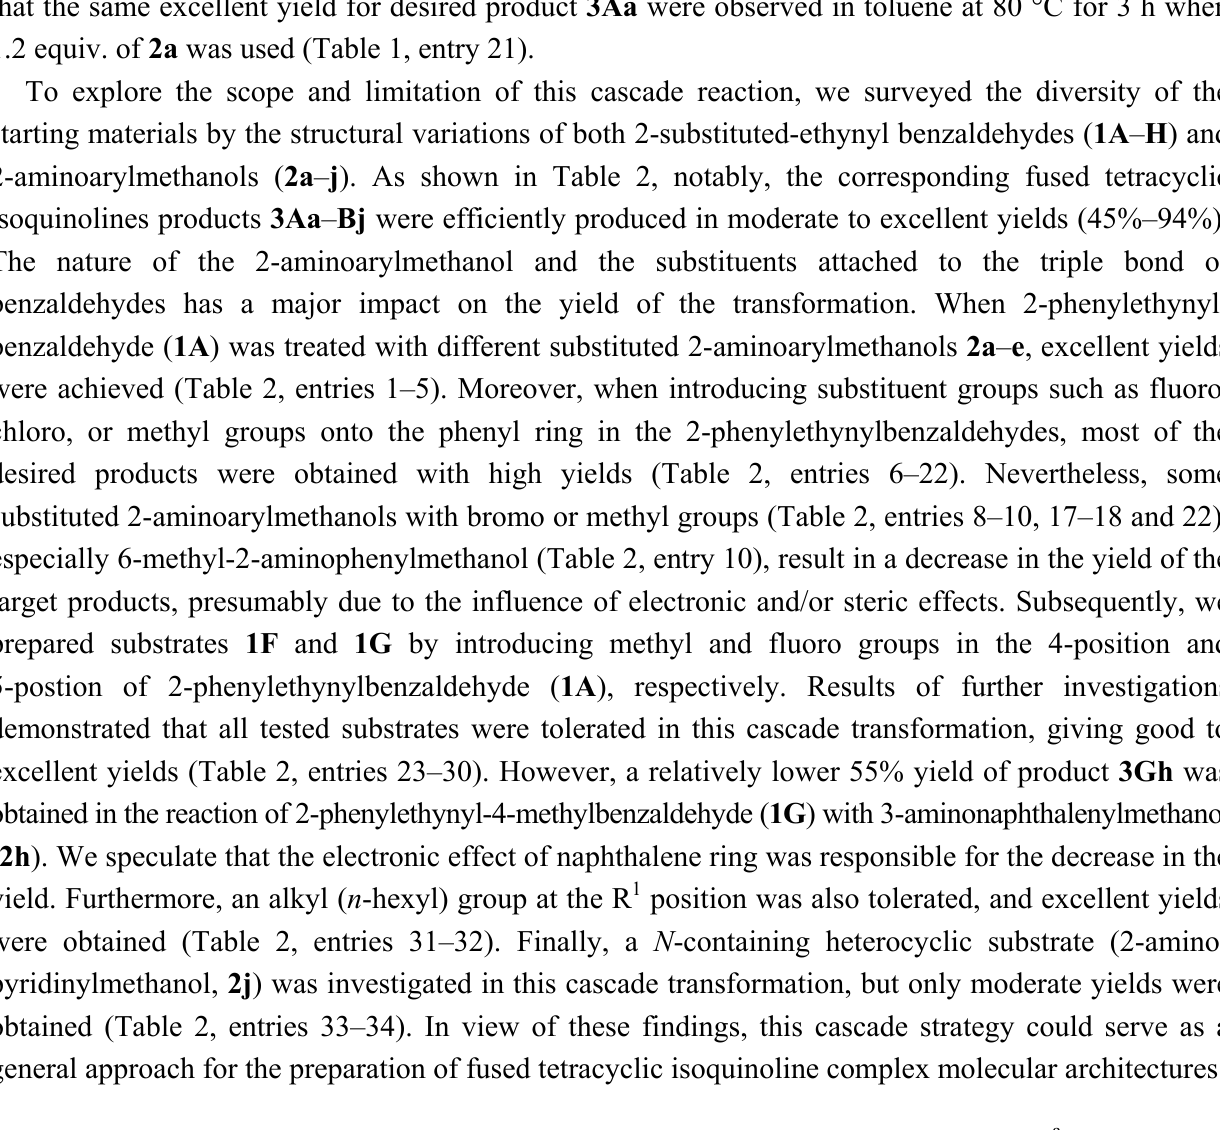
Table 2. Silver-mediated one-pot domino synthesis of target compounds 3 a